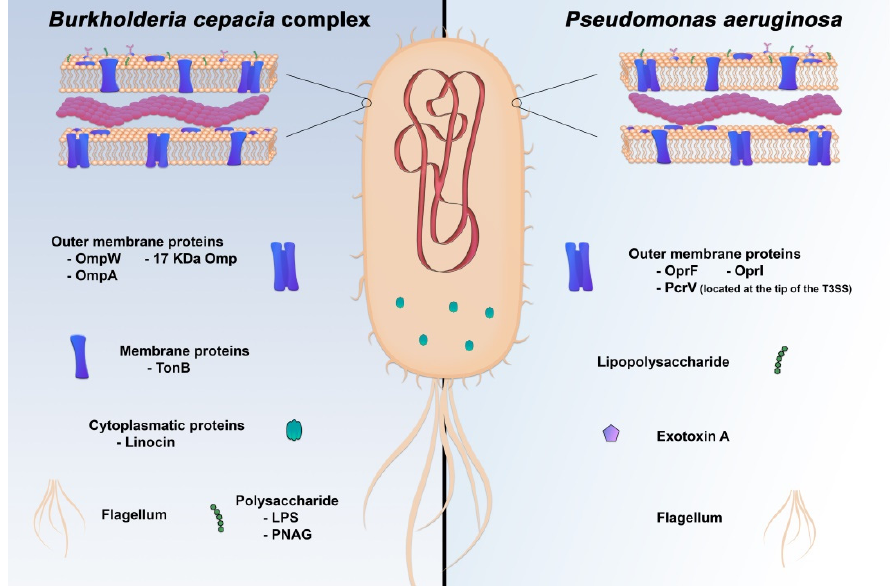
Figure 1. Antigens used in preclinical or clinical trials for development of either active, passive or in combination, vaccines against Bcc or P . aeruginosa infections.